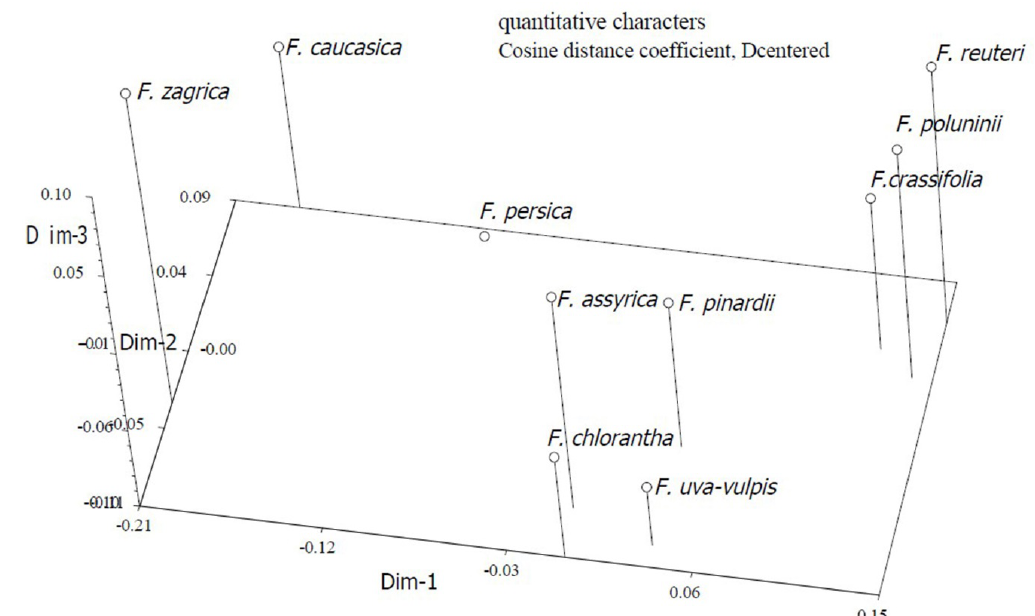
Fig. 4. Plot of PCO analysis of quantitative morphological characters. Four clusters are recognized corresponding to a: major members of group crassifolia of sect. Trichostyleae , b: ( F. zagrica + F. caucasica ), c: sect. Olostyleae , and d: subgen. Theresia